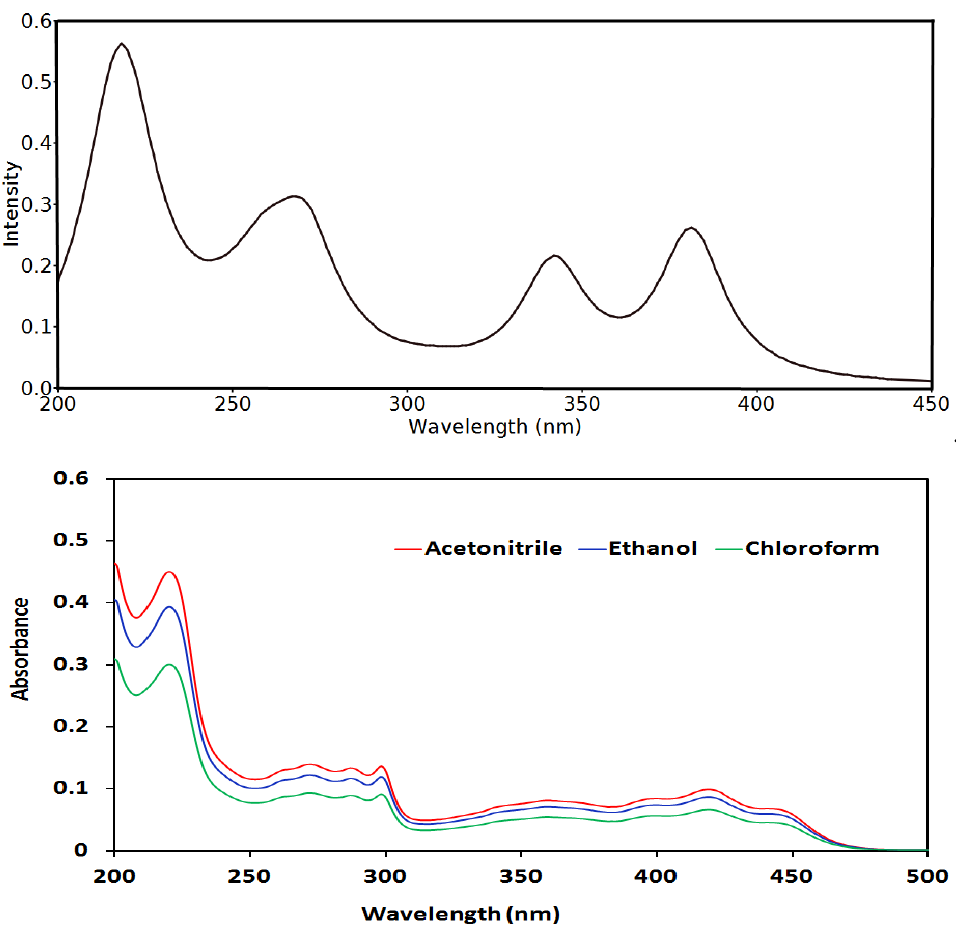
Figure 8. The calculated ( upper ) and experimental ( lower ) electronic spectra of 3 .